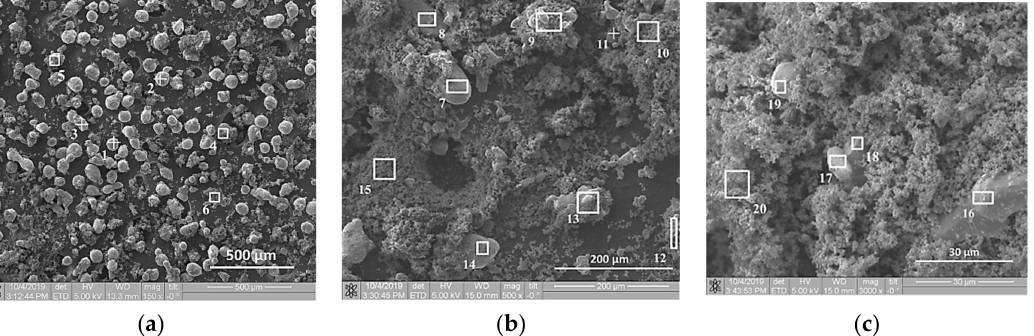
Figure 1. Scanning electron microscope (SEM) images of Al-Ti-B powder particles before planetary milling at di ff erent magnifications: ( a ) 150 × ; ( b ) 500 × ; ( c ) 3000 × .